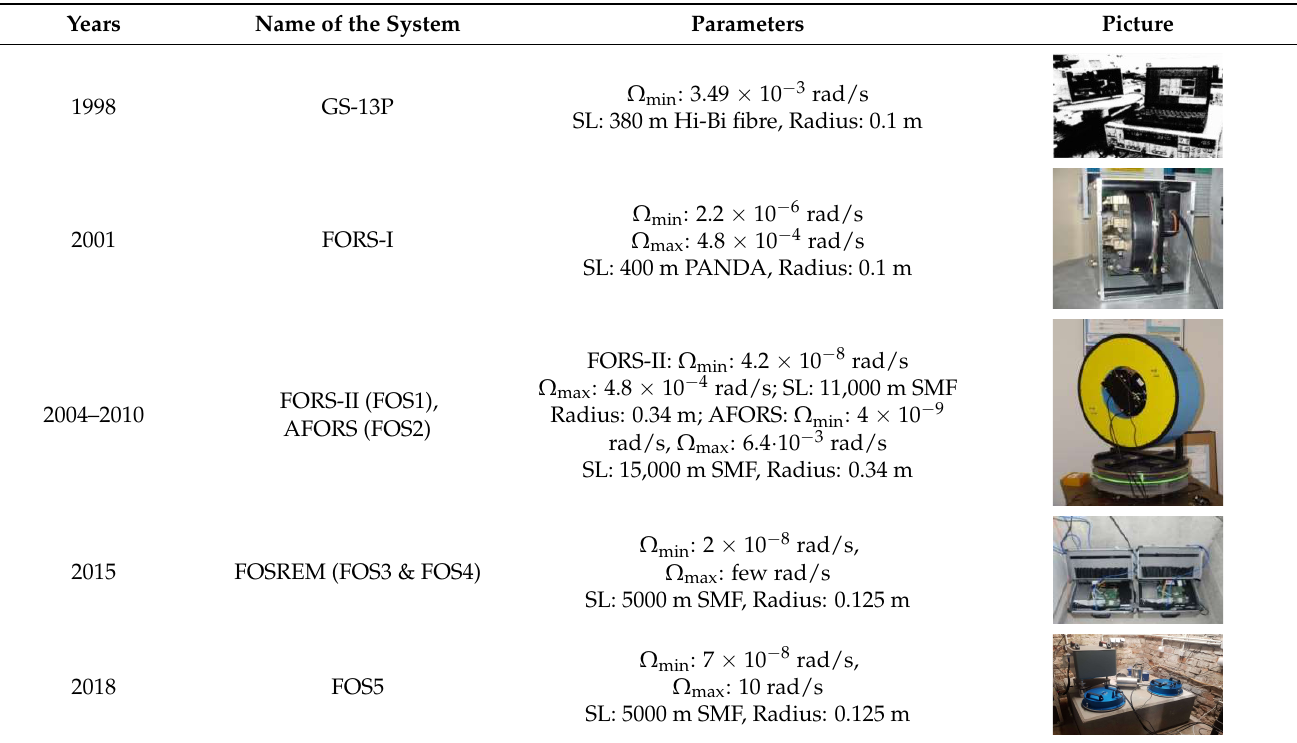
Picture Picture Table 1. Historical brief of the fibre-optic seismograph constructed at the Institute of Applied Physics Table 1. Historical brief of the fibre-optic seismograph constructed at the Institute of Applied Table 1. Historical brief of the fibre-optic seismograph constructed at the Institute of Applied Table 1. Historical brief of the fibre-optic seismograph constructed at the Institute of Applied Table 1. Historical brief of the fibre-optic seismograph constructed at the Institute of Applied at the Military University of Technology, Poland. Physics at the Military University of Technology, Poland. Physics at the Military University of Technology, Physics at the Military University of Technology, Poland. Table 1. Historical brief of the fibre-optic seismograph constructed at the Institute of Applied Physics at the Military University of Technology, Poland. Physics at the Military University of Technology, Poland. Name of the System Parameters Picture Name of the Sys- Years tem